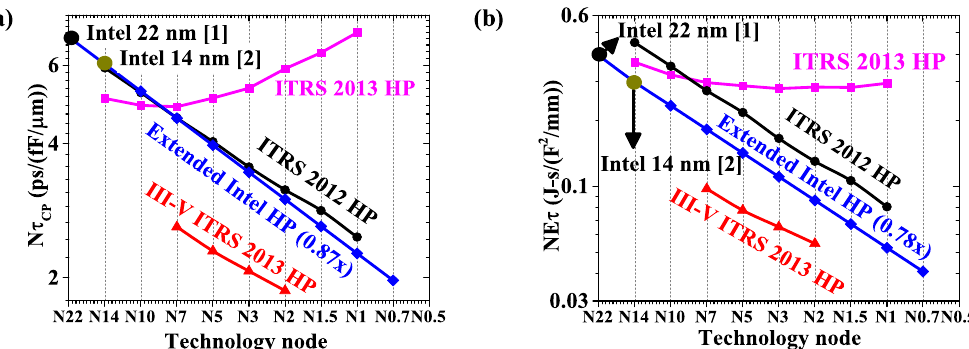
Figure 1. High-performance logic roadmap, ( a ) Normalized delay ( N τ CP ) and, ( b ) Normalized energy-delay product ( NE τ ) with technology nodes for α = 0.1, and L D = 10 (HP